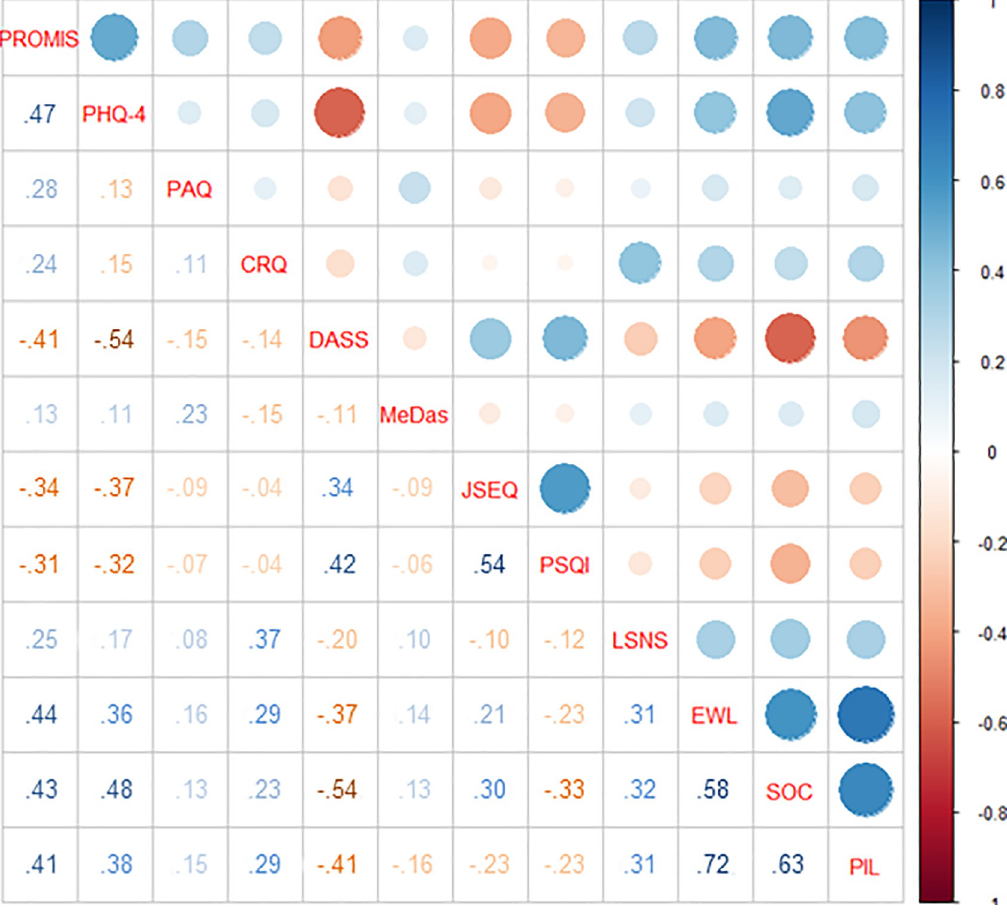
Fig 4. Graphical representations of the correlation’s strength between different lifestyles at baseline. Numbers in the table are ρ coefficients.